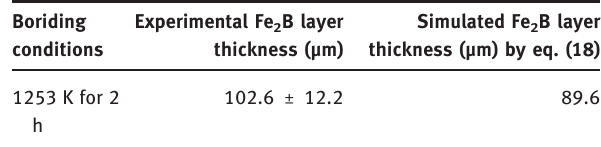
Figure 6: Temperature dependence of the boron diffusion coefficient in Fe 2 B.